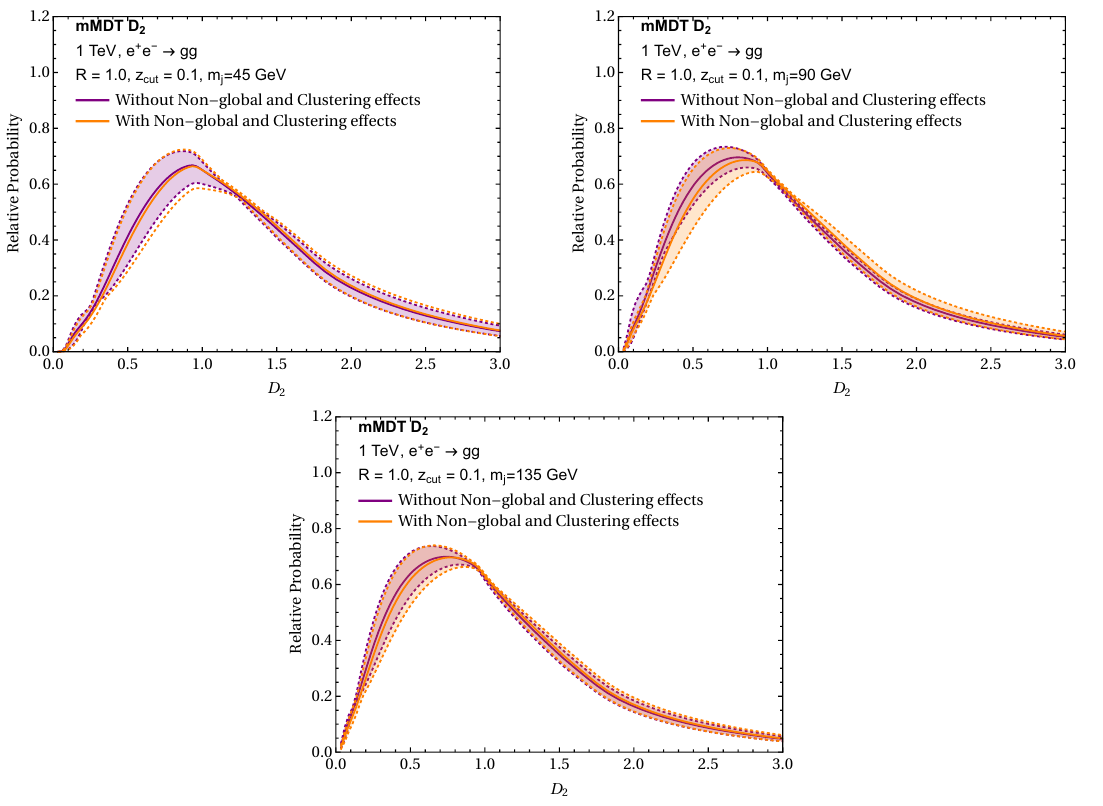
Figure 5 . The D 2 relative probability spectra, for a variety of groomed jet masses for gluon initiated jets, and comparing the change in the spectrum with the inclusion of non-global and clustering